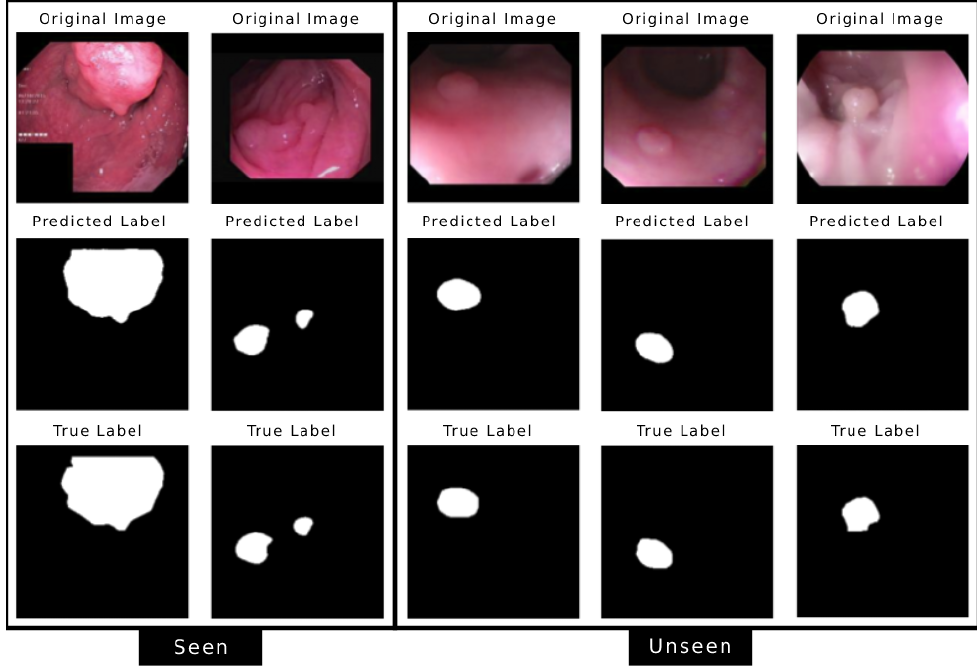
Figure 2. Model’s performance on test images from different datasets (from left) Kvasir, CVC- ClinicDB, CVC-300, Colon-DB, and ETIS where first two are the seen datasets and last three are the unseen datasets.